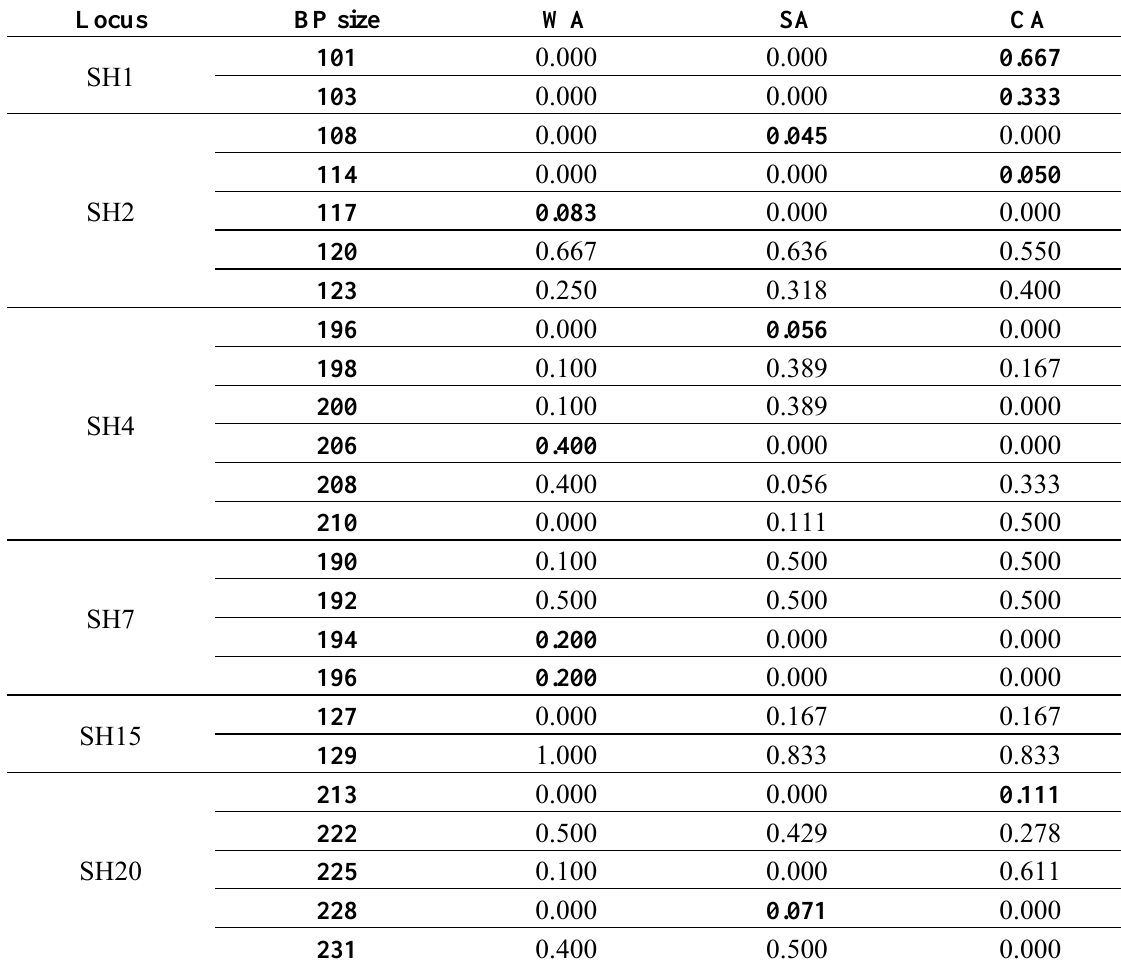
Table 4. Allele size (BP = base pair) of the seven variable microsatellite loci and frequency within Western Australia (WA), Southern Australia (SA) and captive animals (CA). Bold numbers indicate private